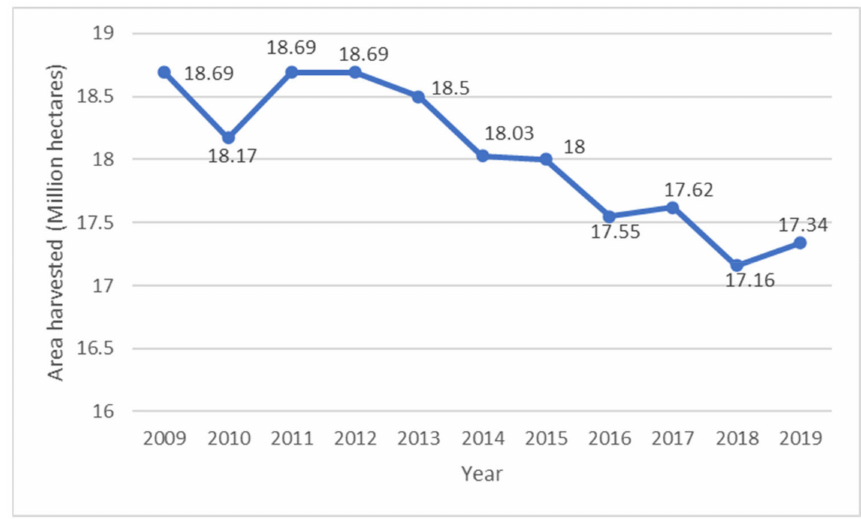
Figure 2. Total area under potato production in the world from 2009 to 2019 [6].